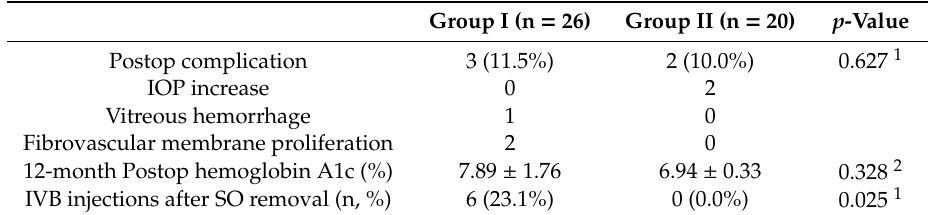
Table 3. Postoperative Complications and Other